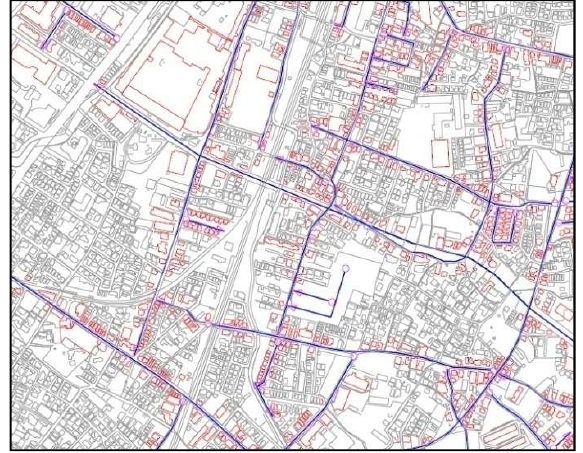
Figure. 8 Extraction of buildings likely to block roads (Blue lines: Roads studied Red squares: Buildings likely to block roads)